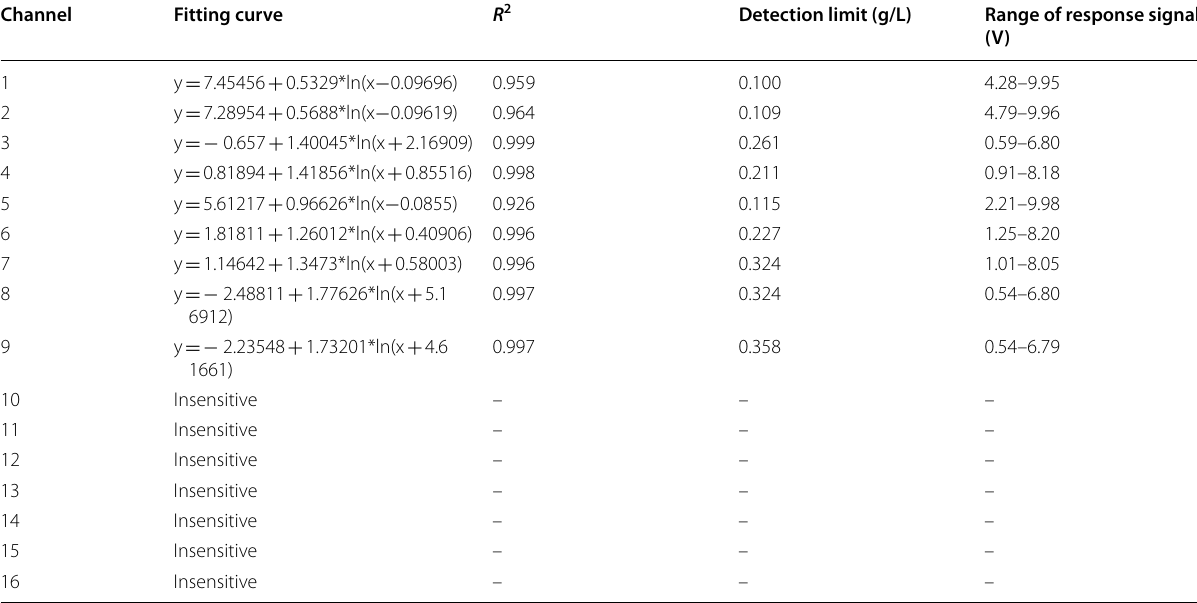
Table 1 Response analysis of different channels to different ethanol concentrations Channel Fitting curve R